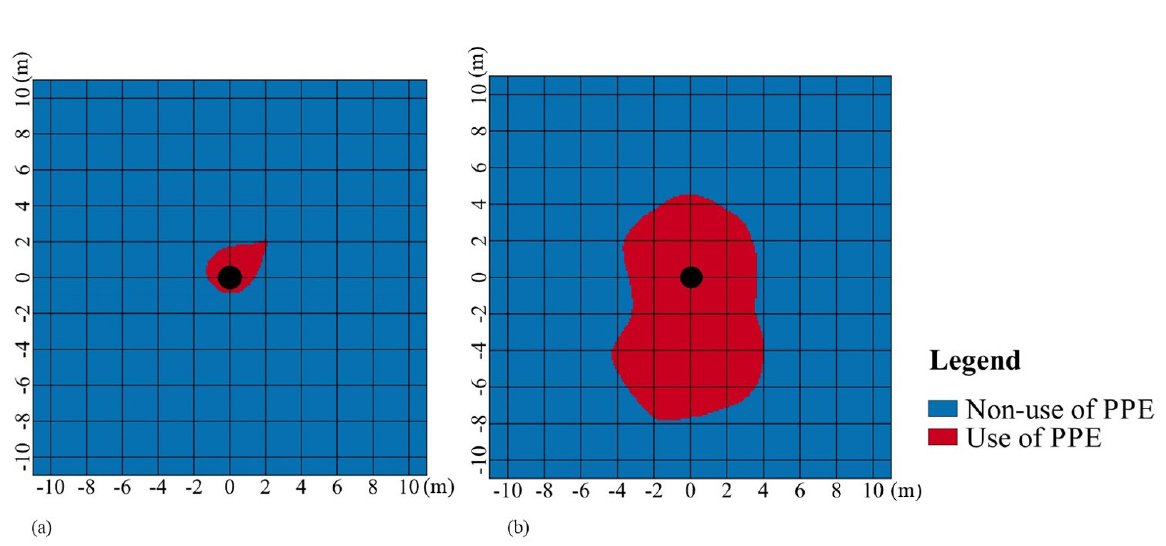
Figure 5. Map of the need for the use or not of PPE. (a) without rotary cutter activation (b) with rotary cutter